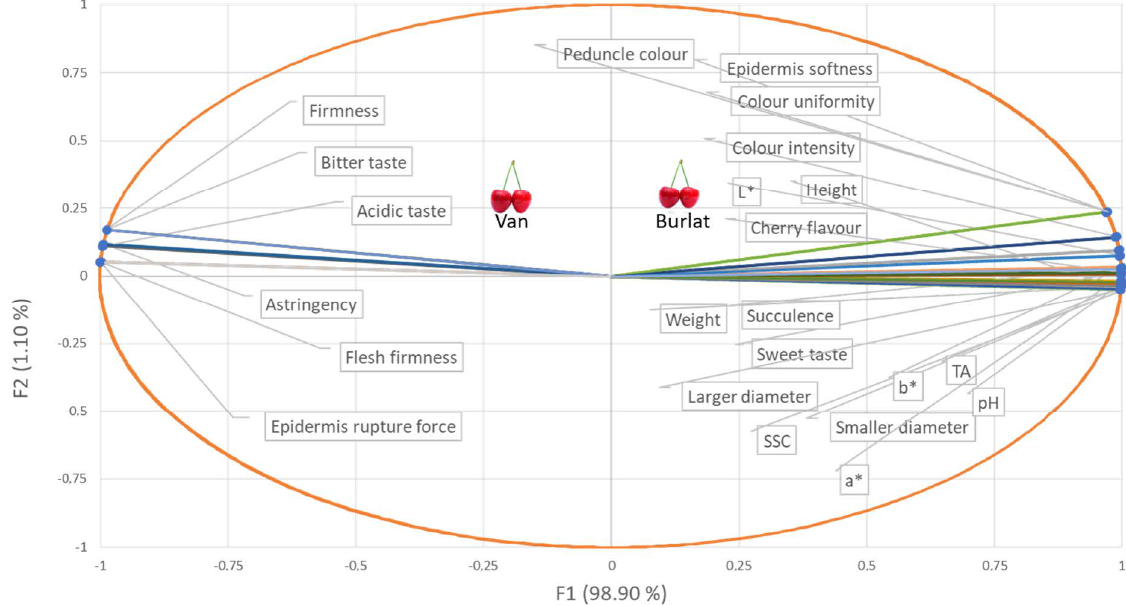
Figure 6. Principal component analysis (Pearson correlation) with factor 1 (F1) and factor 2 (F2) was obtained by analysis of sensory and analytical data of the two sweet cherry cultivars (Van and Burlat).